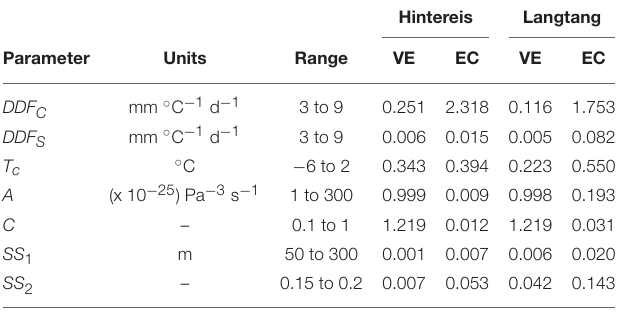
The values between the parentheses represent the minimum and maximum of the calibrated surface velocities and elevation changes. TABLE 4 | Model parameters and parameter ranges used for the sensitivity